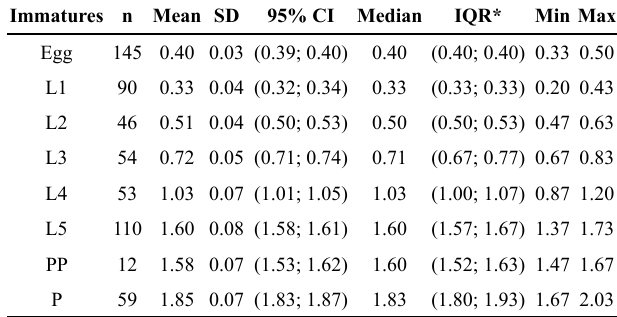
to the long post-embryonic development of social wasps. It is Table 1 – Descriptive statistics of the widths (mm) of the eggs and the cephalic capsules of the larvae (L1 – L5), pre-pupae (PP), and pupae (P) of Mischocyttarus nomurae (Hymenoptera, Immatures n Mean SD